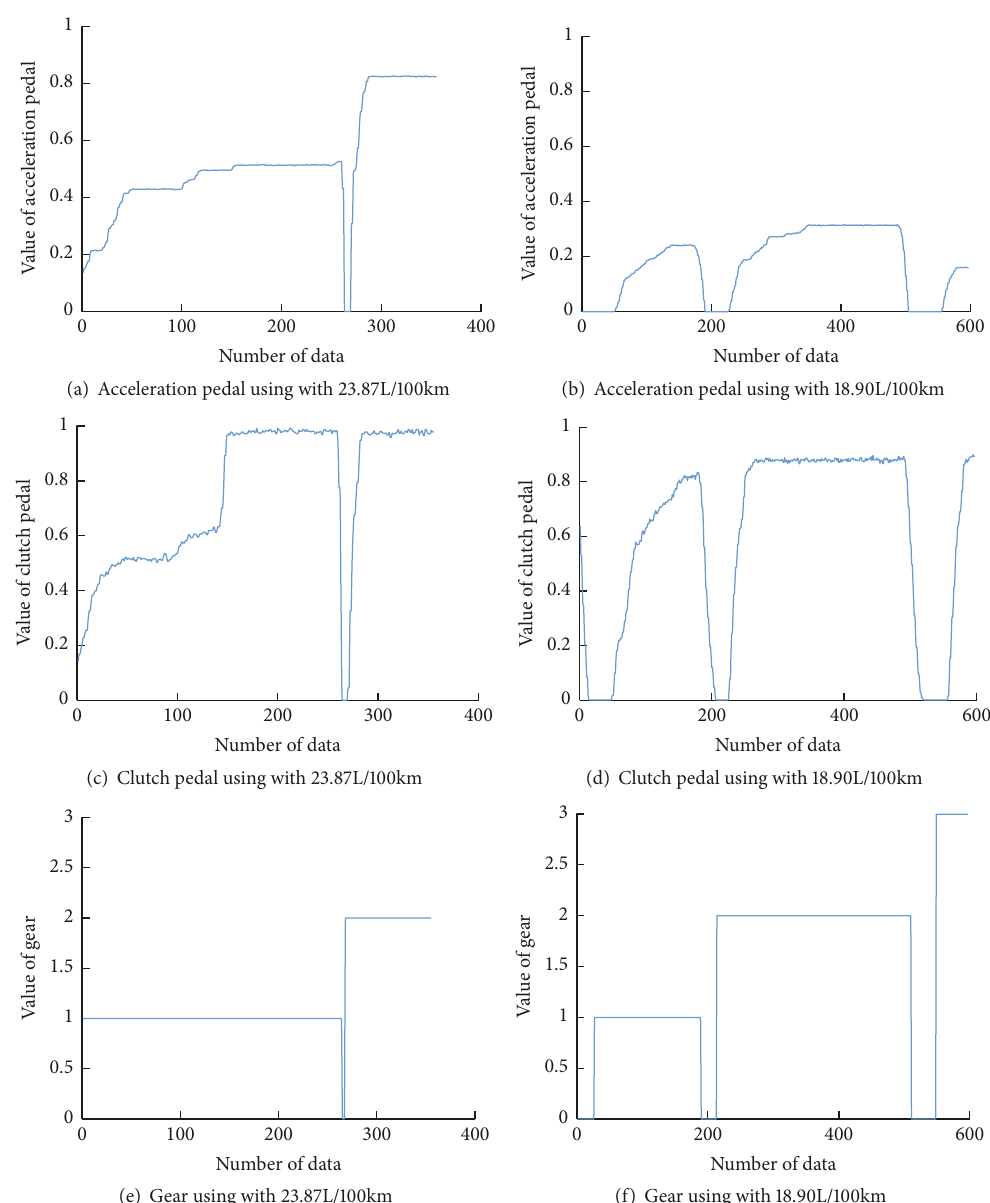
Figure 2: Driver performance in vehicle starting process with different fuel